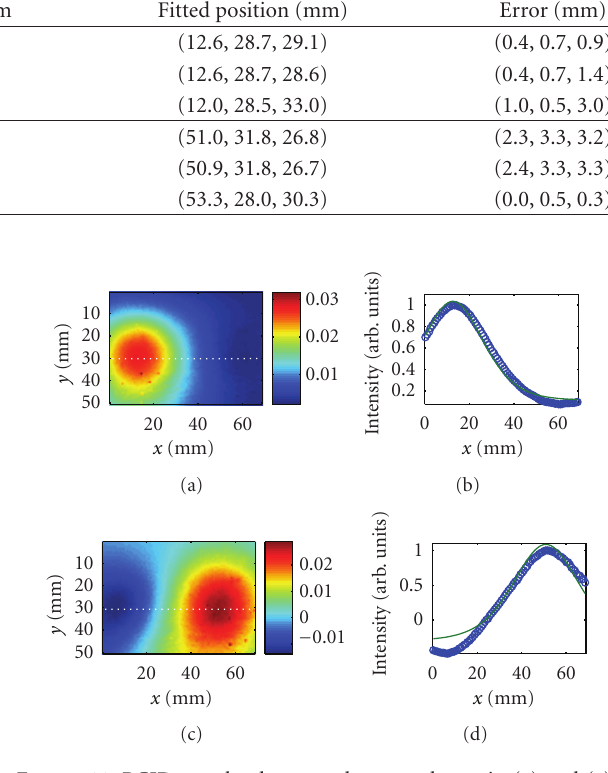
Figure 11: PCIDs on the detector plane are shown in (a) and (c); corresponding Green’s function fits to the horizontal spatial profiles through the dashed line are shown in (b) and